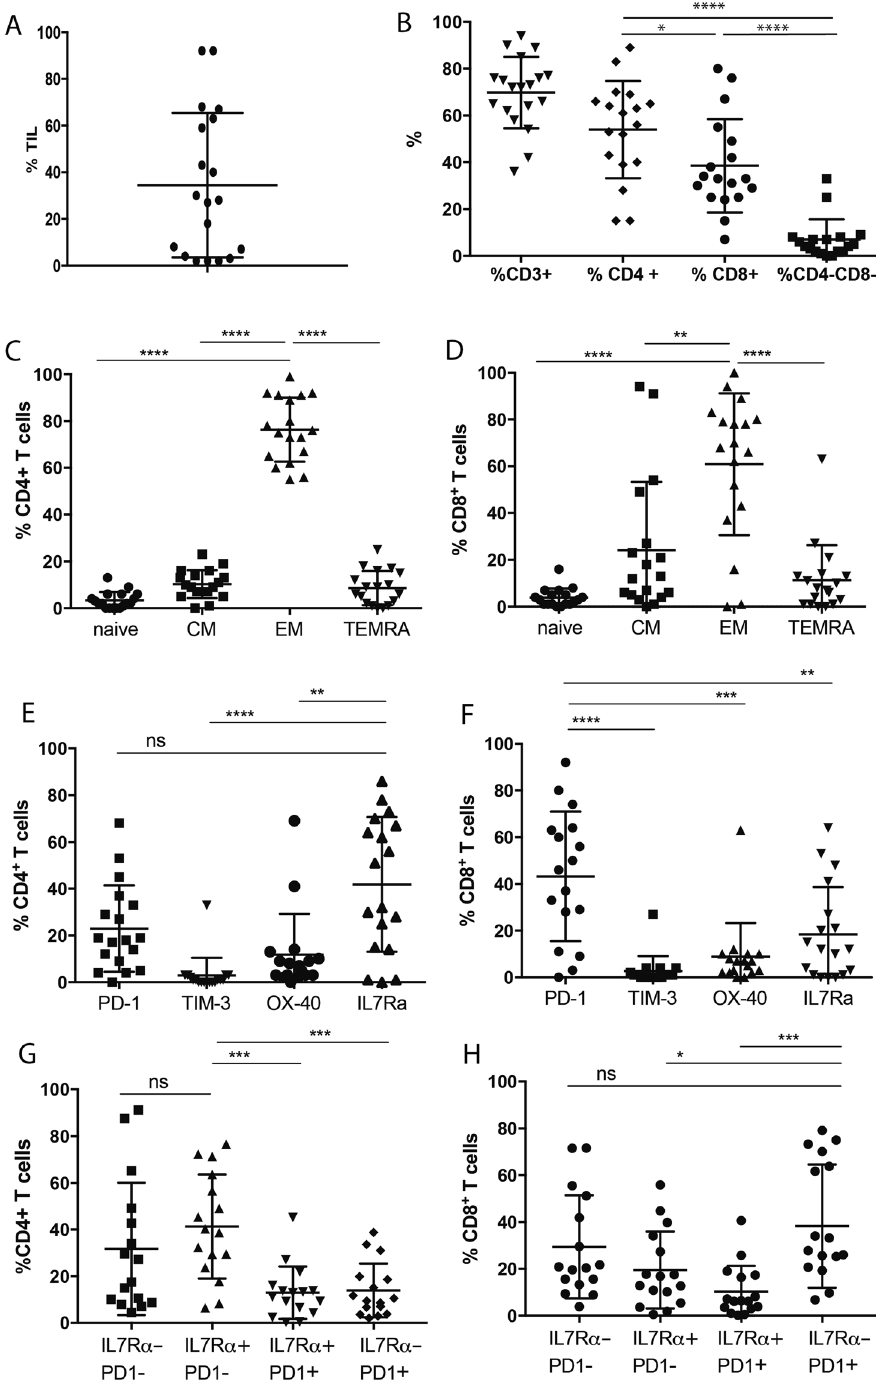
Figure 3. Melanoma TILs. Melanoma metastases were analysed by FACS (gating strategy as per Supplementary Fig. 6) to characterize the T cells present. Viable cells were assessed for ( A ) % TILs (HLA-ABC + CD45 + ), and ( B ) T cell subsets. In addition, T cell compartments in ( C ) CD4 + T cells, and ( D ) CD8 + T cells; immune checkpoints and activation markers in ( E ) CD4 + T cells, and ( F ) CD8 + T cells, and PD-1 expression by T cell compartments in ( G ) CD4 + T cells, and ( H ) CD8 + T cells. Finally, relative expression of IL-7R α and PD-1 was assessed in ( I ) CD4 + T cells, and ( J ) CD8 + T cells. Data is presented as % + for each marker; statistical analysis (Mann Whitney) was performed across the cohort, significantly different data is represented by * (p < 0.05), ** (p < 0.01), *** (p < 0.001) and **** (p <